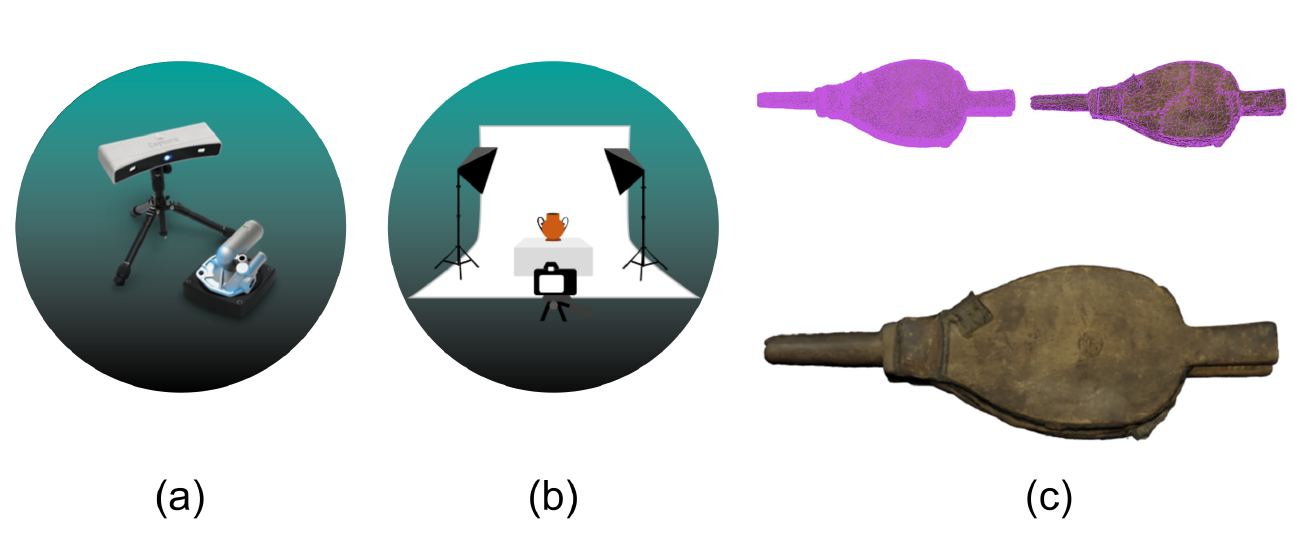
Figure 2. Digitization process: ( a ) 3D scanner technology; ( b ) photogrammetry technology; ( c ) optimization process of the three-dimensional model of a bellows using Autodesk 3ds Max